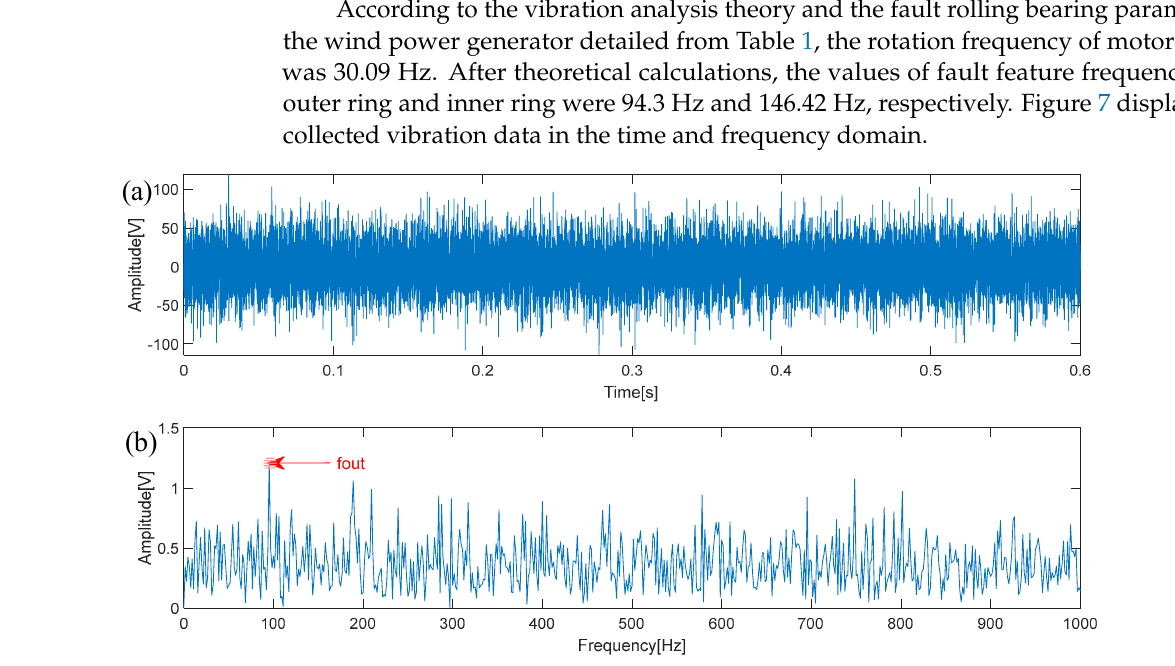
Figure 7. Waveform and spectra of outer ring bearing vibration signals of wind power